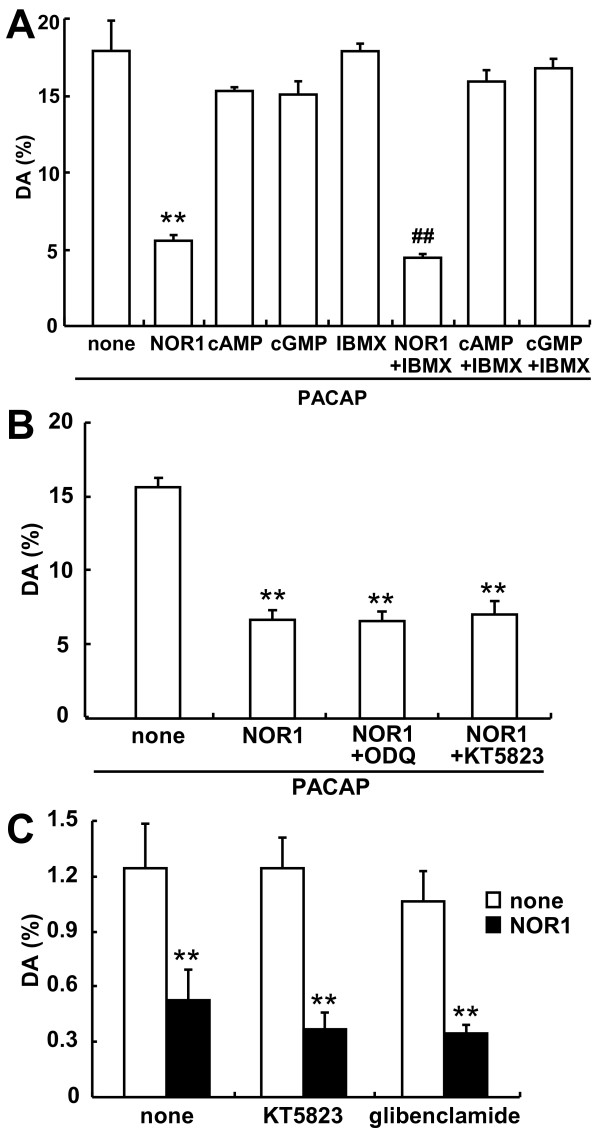
No mediation of the cGMP/PKG pathway in inhibition of dopamine release by NOR1. A. Effect of membrane-permeable cGMP and cAMP analogues on PACAP-stimulated dopamine release. PC12 cells (4 × 105 cells/well) cultured on 24-well dishes were stimulated for 10 min with 10 nM PACAP and 100 μM NOR1, 8-Br-cAMP or 8-Br-cGMP in the absence or presence of 100 μM IBMX. **P < 0.01 vs. none; ##P < 0.01 vs. IBMX. B. Effect of inhibitors of the cGMP/PKG pathway on PACAP-stimulated dopamine release by NOR1. PC12 cells were preincubated for 30 min with 100 μM NOR1 and 300 nM ODQ or 1 μM KT5823 in the presence of 10 μM imipramine. Then the cells were stimulated for 5 min by the addition of 10 nM PACAP. **P < 0.01 vs. PACAP alone (none). C. Effect of inhibitors of the cGMP/PKG pathway on basal dopamine release. PC12 cells were incubated for 5 min with 1 μM KT5823 or 1 μM glibenclamide without or with 100 μM NOR1. Dopamine was measured by HPLC, and dopamine released into the medium (mean ± SD, n = 3) was expressed as a percentage of total dopamine in PC12 cells, as described in "Methods." **P < 0.01 vs. none.